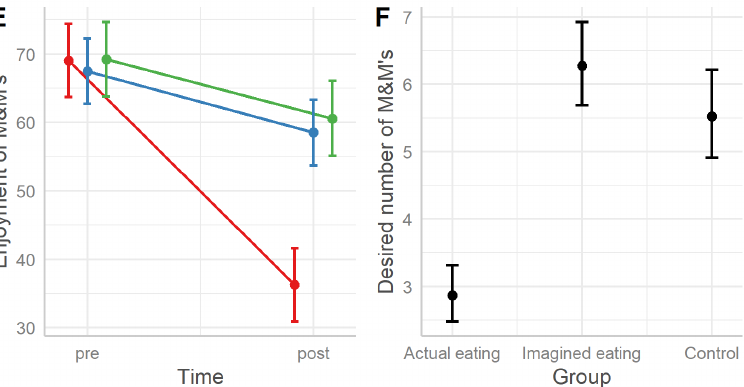
Figure 4. Statistical model predictions. Panels A – D show participants’ eating desires before (pre) and after (post) experiment. Furthermore, panels A , B , and D illustrate group differences, whereas the groups in panel C have been pooled due to no differences. Panel E shows the enjoyment of a tasted orange M&M before (pre) and after (post) the experiment between the groups. Panel F shows the desired number of M&Ms between the groups after the experiment.